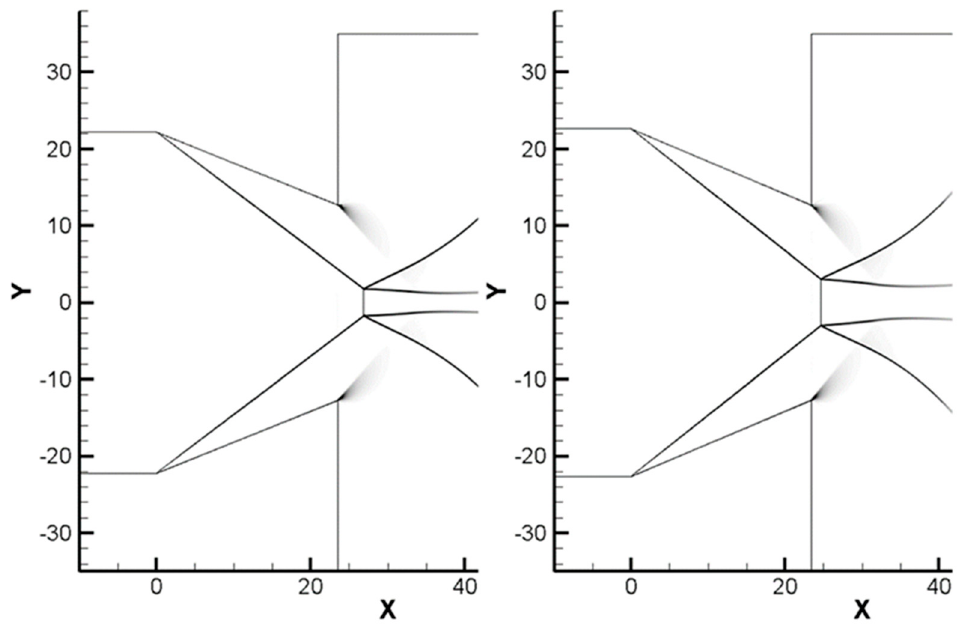
Figure 6. Transition of shock reflection for the 1D gap ( left , 22° wedge/ right , 23° wedge).